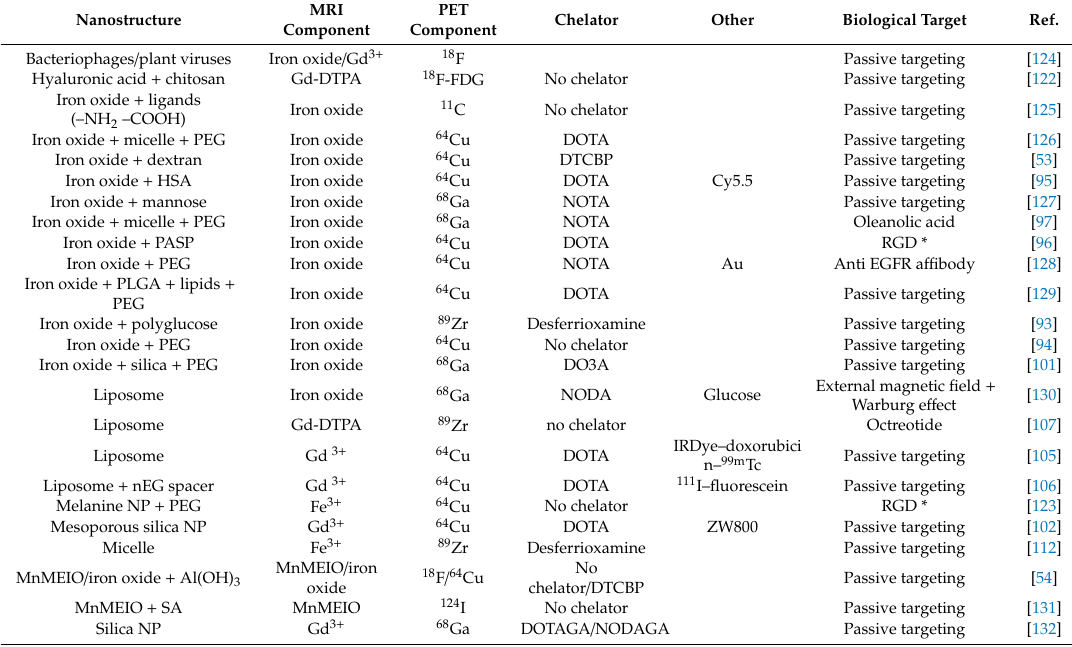
Table 4. Overview of multimodal PET / MRI